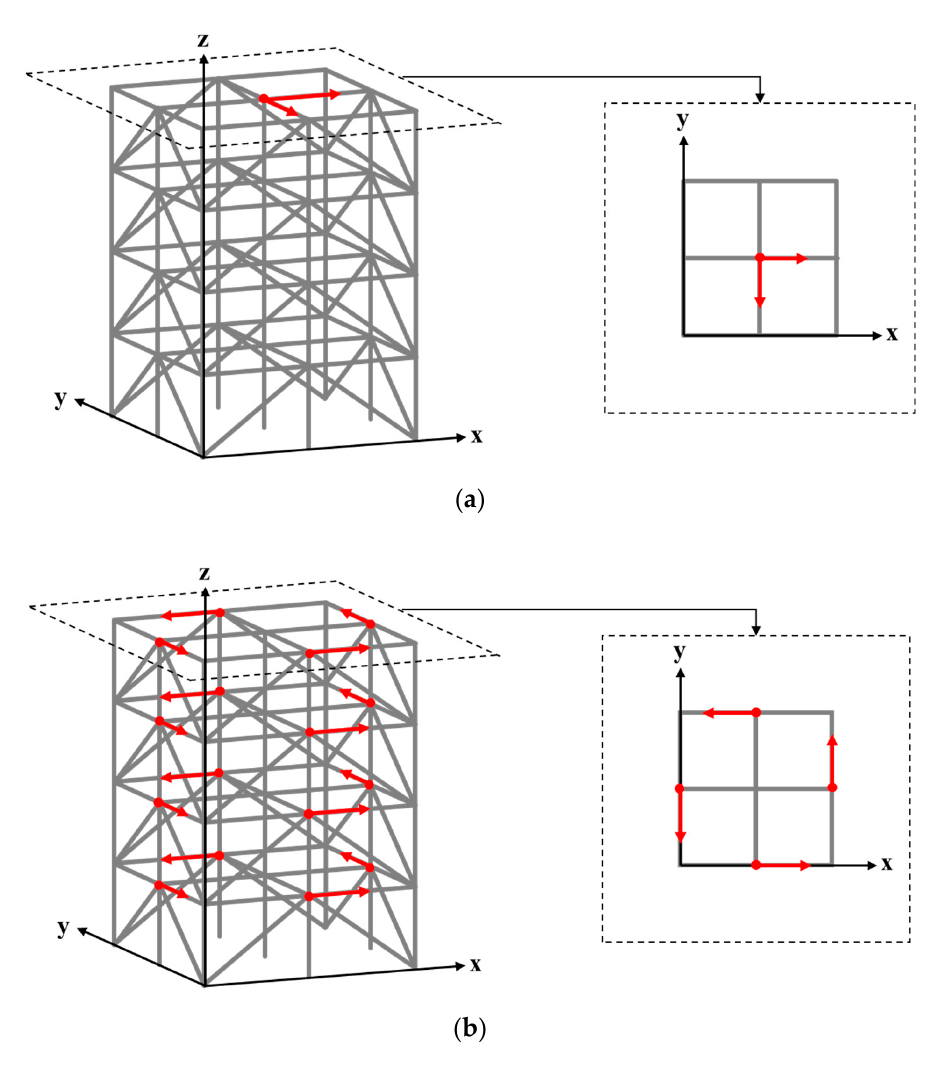
Figure 9. The locations at which ( a ) reference and ( b ) non-reference acceleration dynamic responses were captured from the structure along the x and y directions.